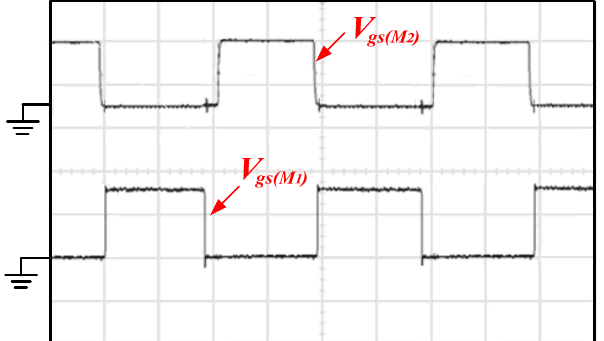
. ( V : 200 V/div; 1 DS